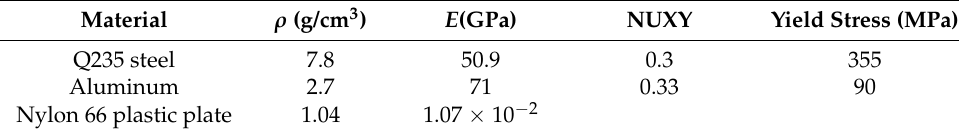
Table 2. Material parameters of different target